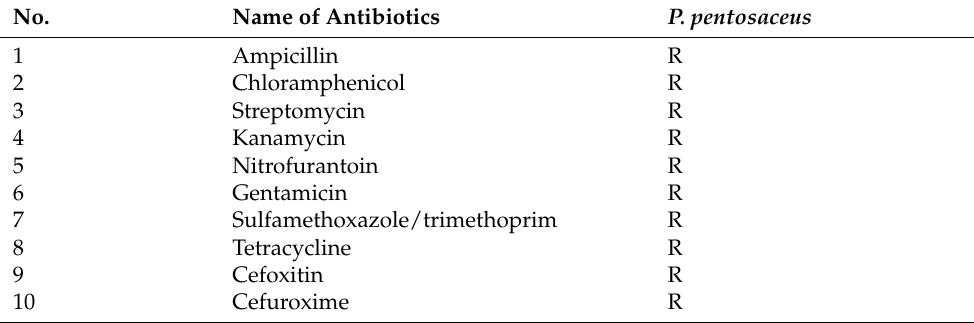
Table 1. Antibiotic sensitivity assay.